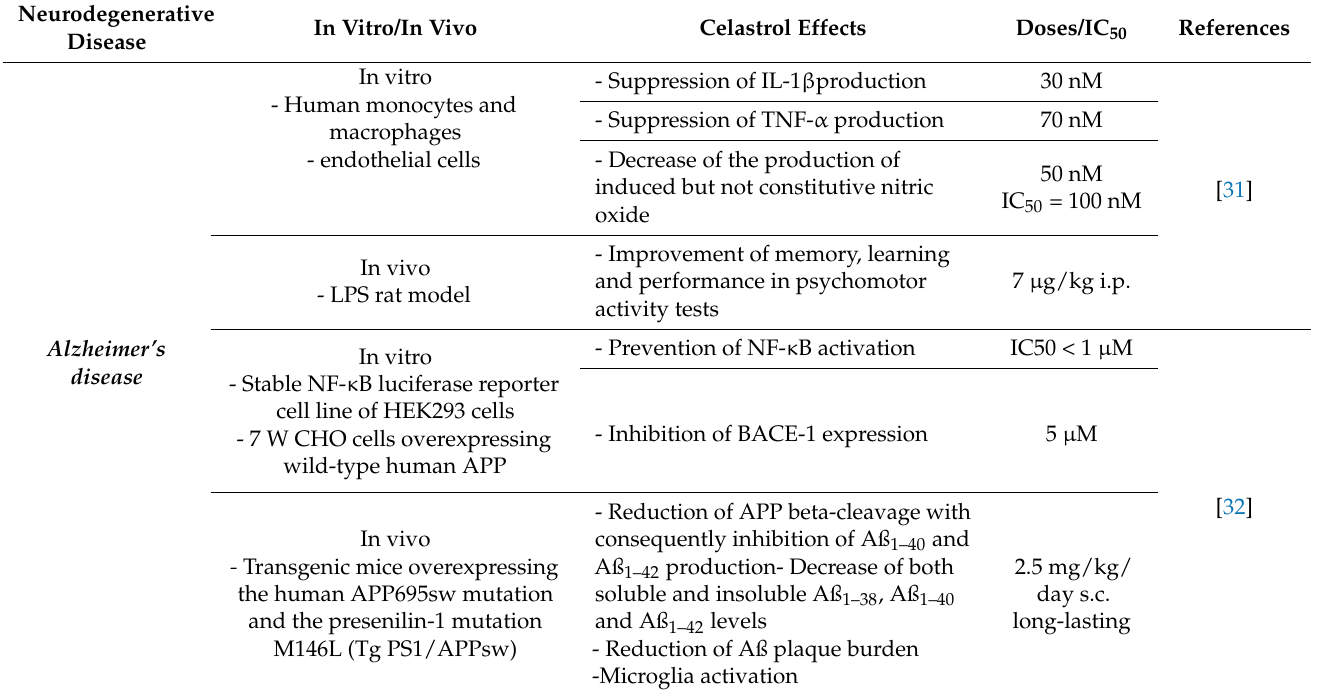
Table 1. Effects of celastrol in Alzheimer’s disease, Parkinson’s disease, and Amiotrophyc lateral sclerosis. Neurodegenerative In Vitro/In Disease